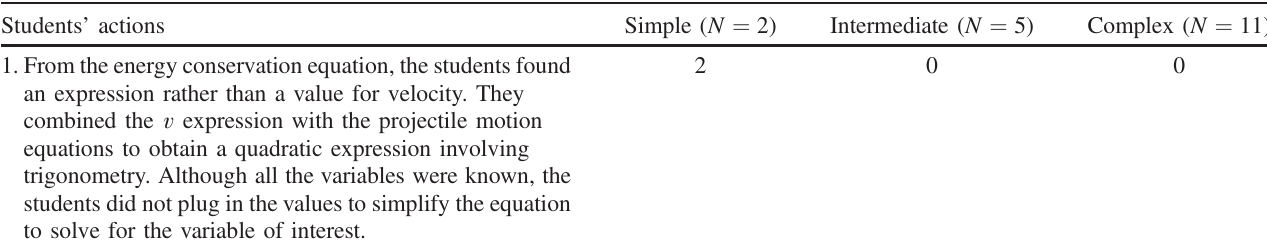
TABLE IV. Actions of those students who did not simplify their equations after combining them for the simple, intermediate and complex sequential synthesis